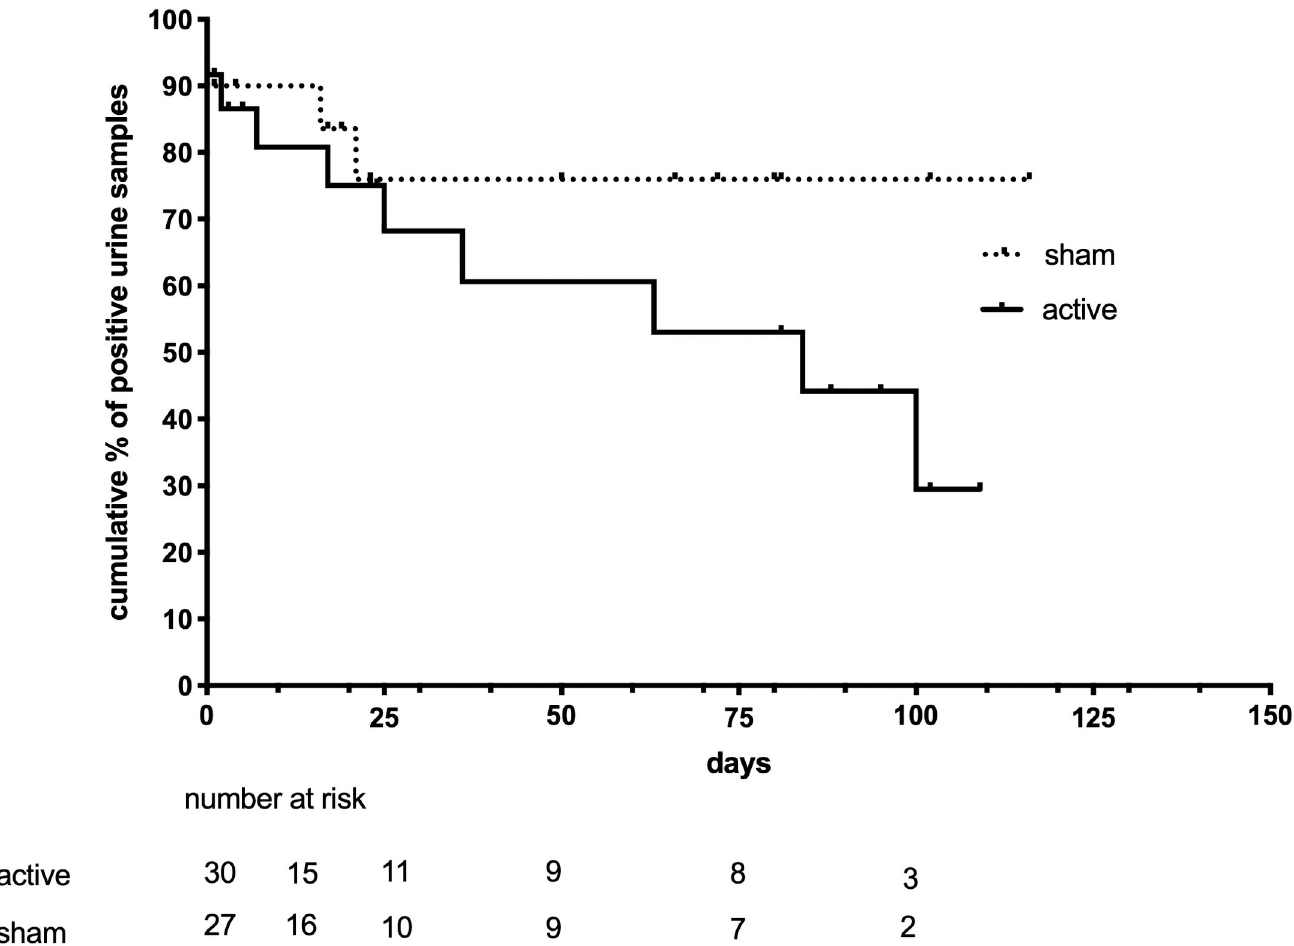
Fig 2. Cumulative proportion of positive urine samples and numbers at risk in active rTMS and sham-treated group with time (days). The Mantel-Cox test is p = 0.20. Tics indicate censored patients.